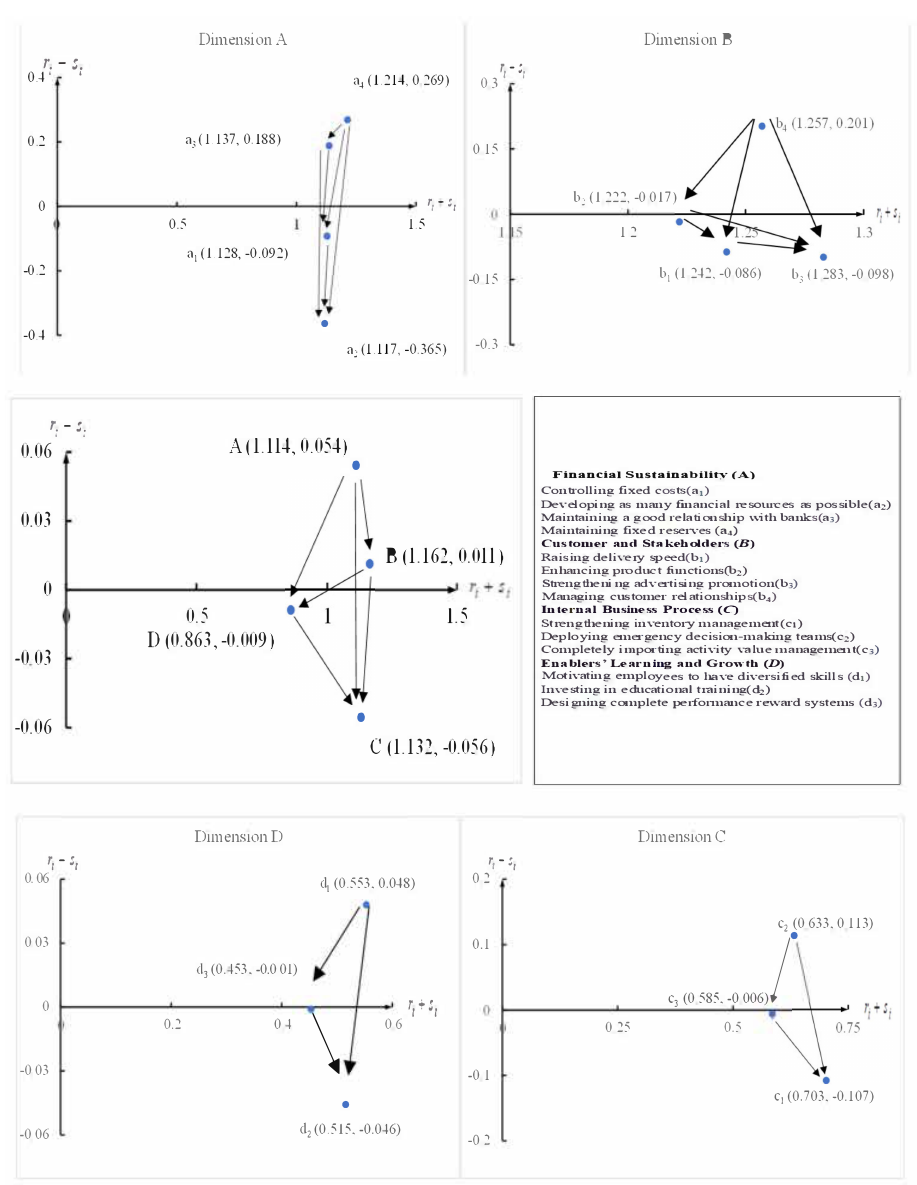
Figure 1. The INRM results of the influence relationships based on